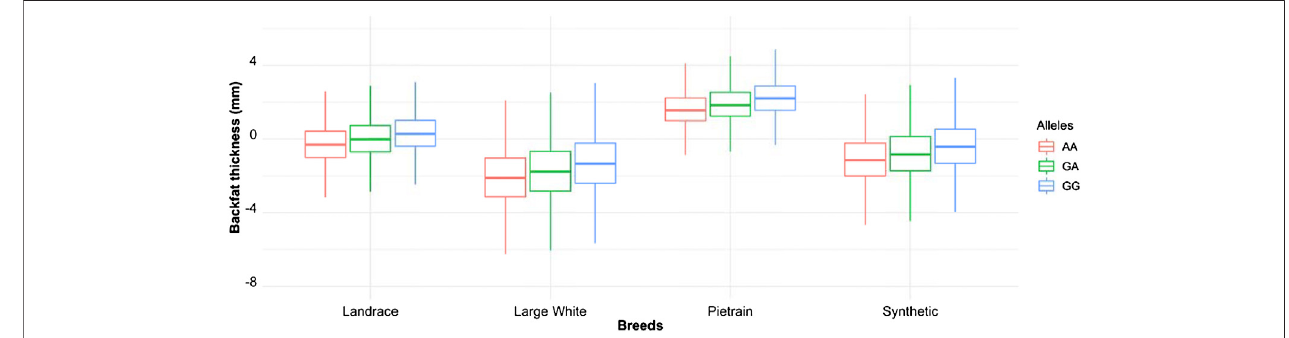
FIGURE 2 | Boxplot showing the additive effect of the rs80985094 G/A allele on backfat among the different populations. Phenotype is backfat thickness in mm.